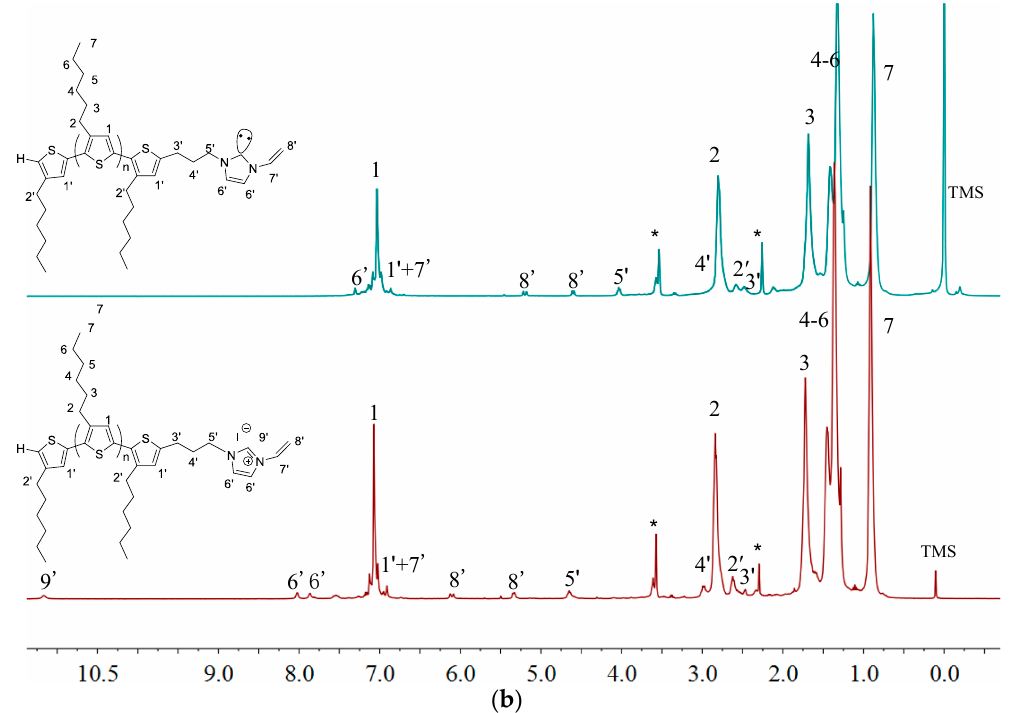
Figure 8. Overlay of 1 H-NMR (THF- d 8 ) spectra of P3HT-(CH 2 ) 3 -MIM ( a ) and P3HT-(CH 2 ) 3 -VIM ( b ) before and after deprotonation. Peaks marked * correspond to residual NMR solvent signals.